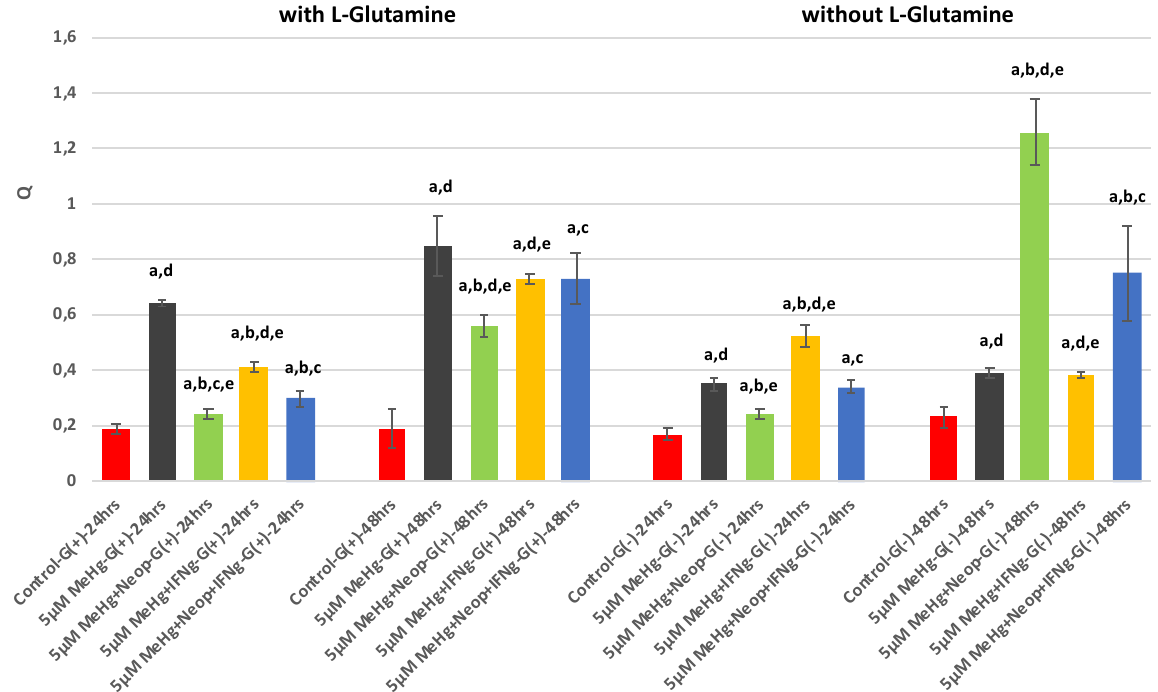
Figure 1. Oxidative stress coefficient of MetHg-exposed SH-SY5Y human neuroblastoma cell line in glutamine containing and glutamine-free medium at the end of 24 and 48-hour periods. ( IFNg: Interferon-gamma; MetHg: Methylmecury; G: L-glutamine; Q:[(NOx/Cc )/(MTT/Cc)], oxidative stress coefficient ).